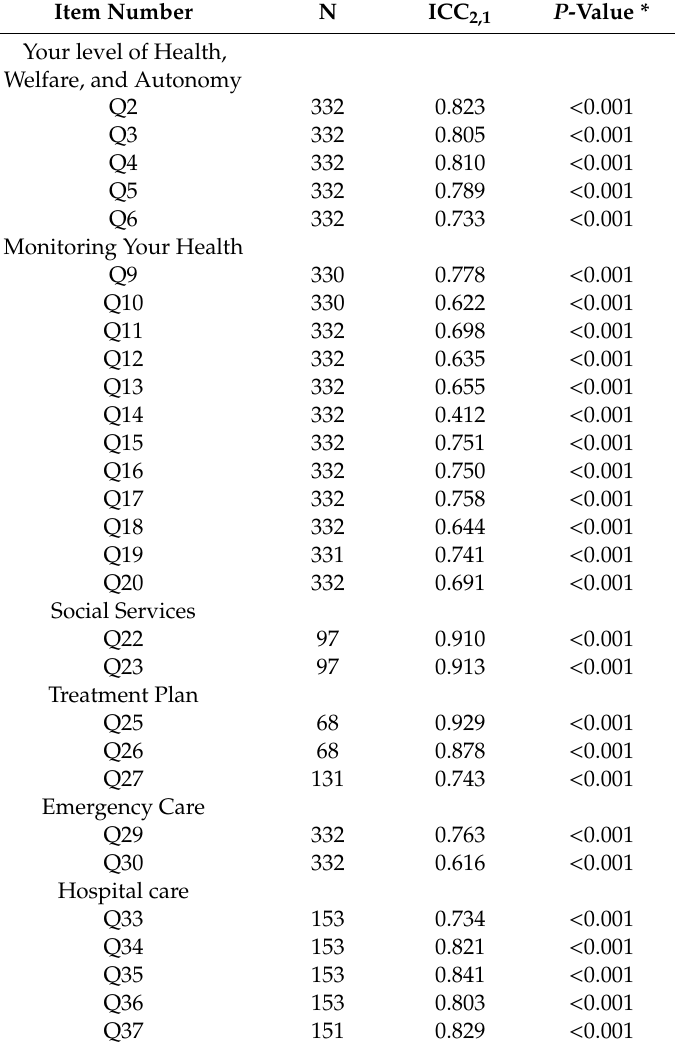
Table 4. Test–retest